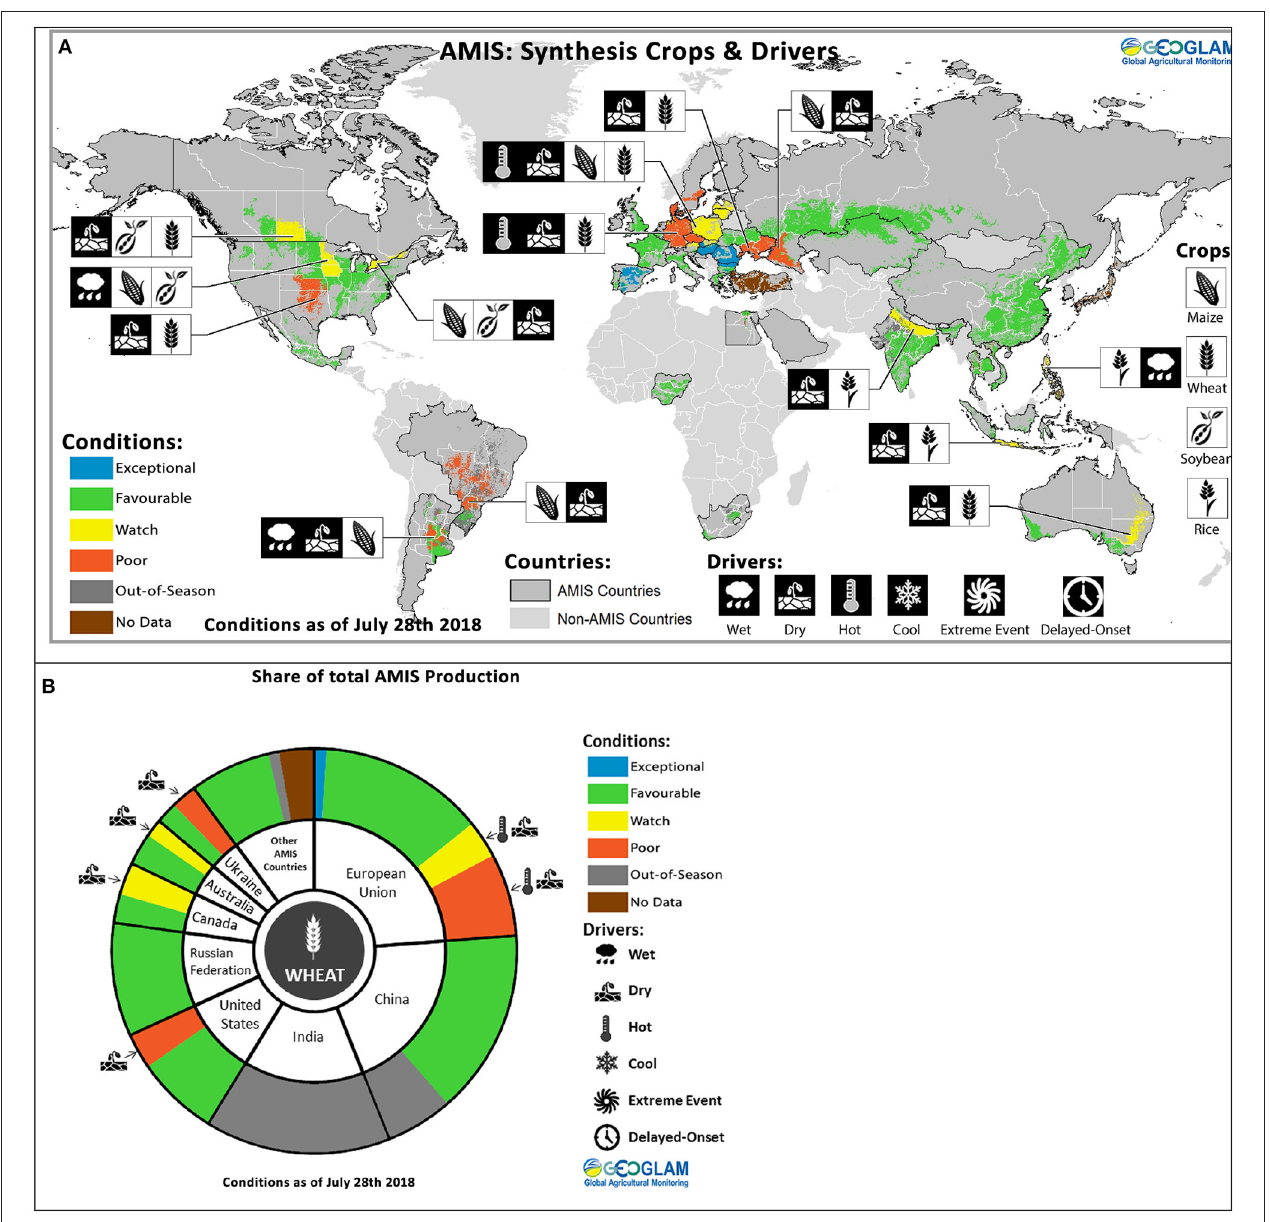
FIGURE 2 | (A) July 2018 CM4AMIS contains maps of conditions and their associated drivers (wet, dry, hot, cold, extreme event). (B) Pie charts show conditions of specific crops, e.g., July 2018 wheat, by share of global production and global